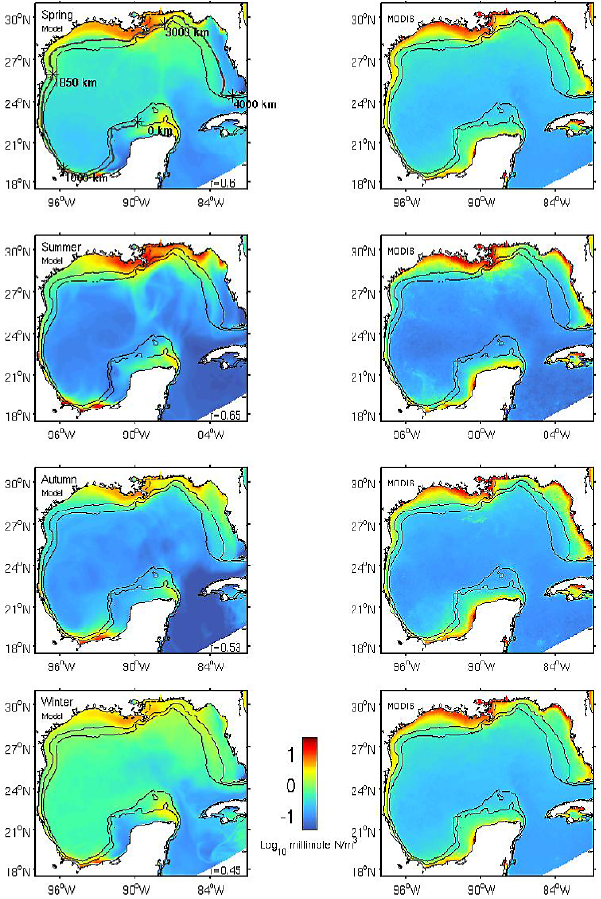
Fig. 8. Comparison of simulated (left panels) and MODIS observed (right panels) seasonal mean surface chlorophyll. Also shown in each panel are 50 (labeled with distance) and 200m isobaths.